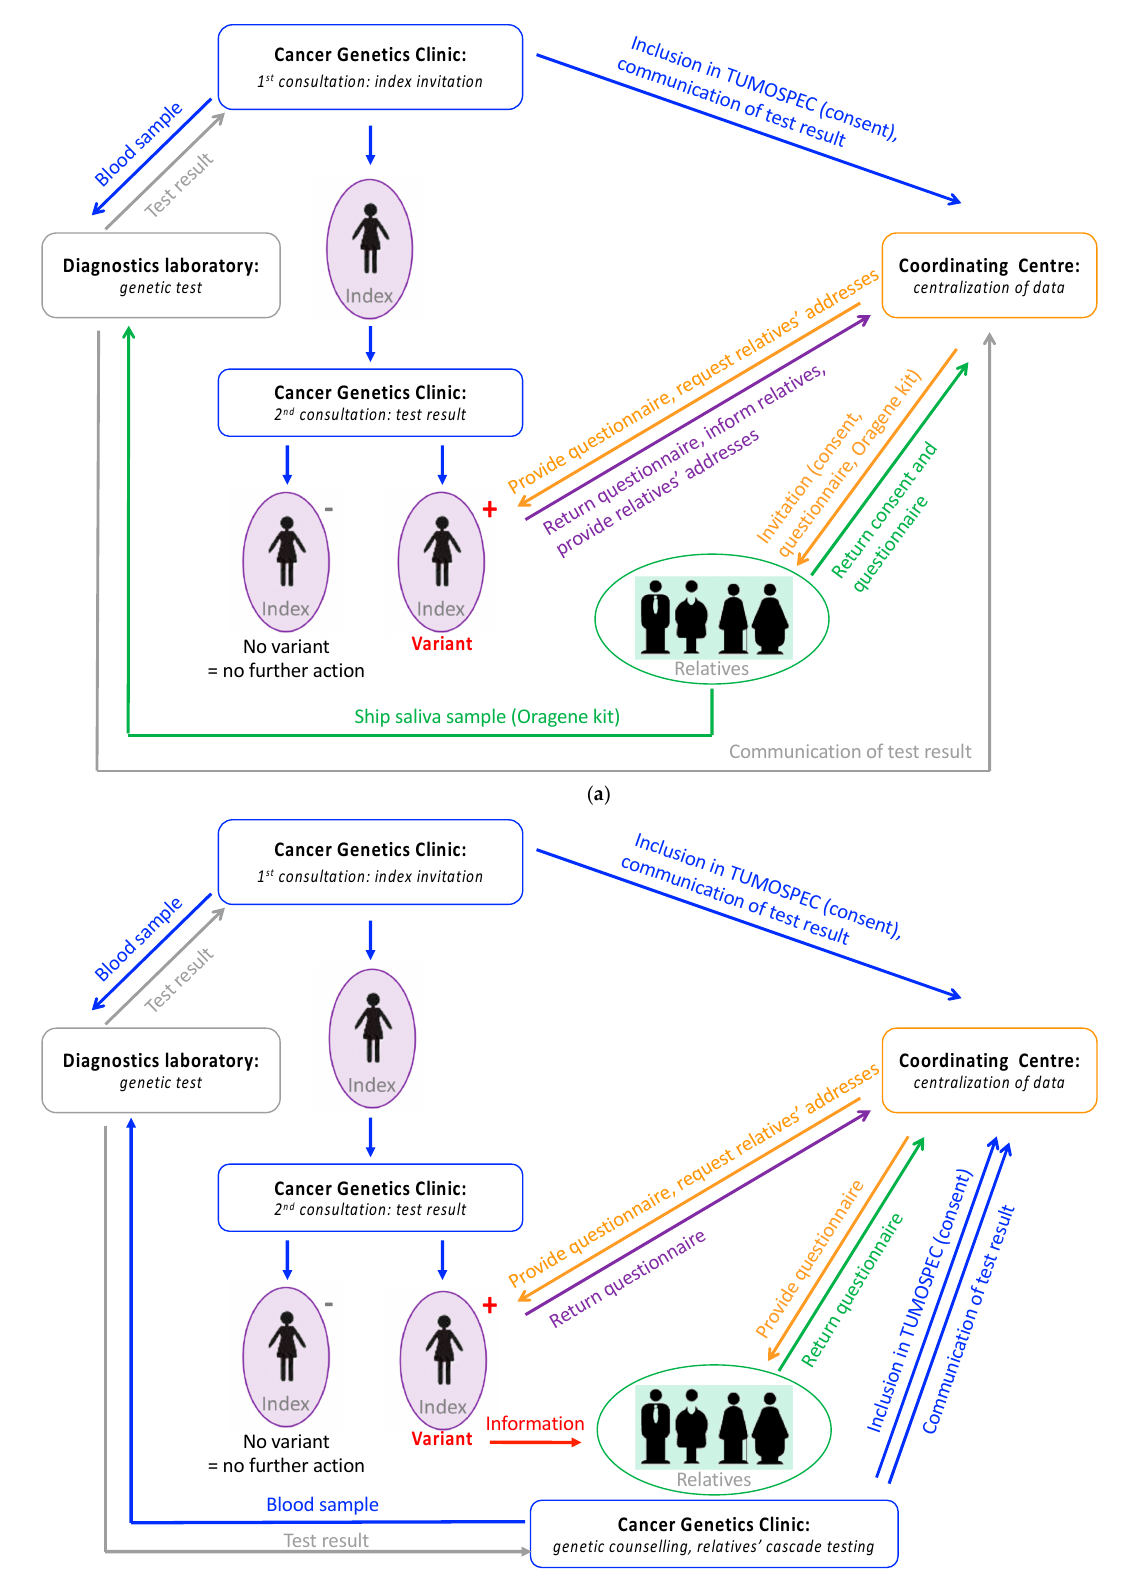
Figure 1. TUMOSPEC protocol. ( a ) Process for the collection of data in families segregating a variant in a gene from sub-panel A or a variant of unknown clinical significance in a gene from sub-panel B. ( b ) Process for the collection of data in families segregating a pathogenic variant in a gene from sub-panel